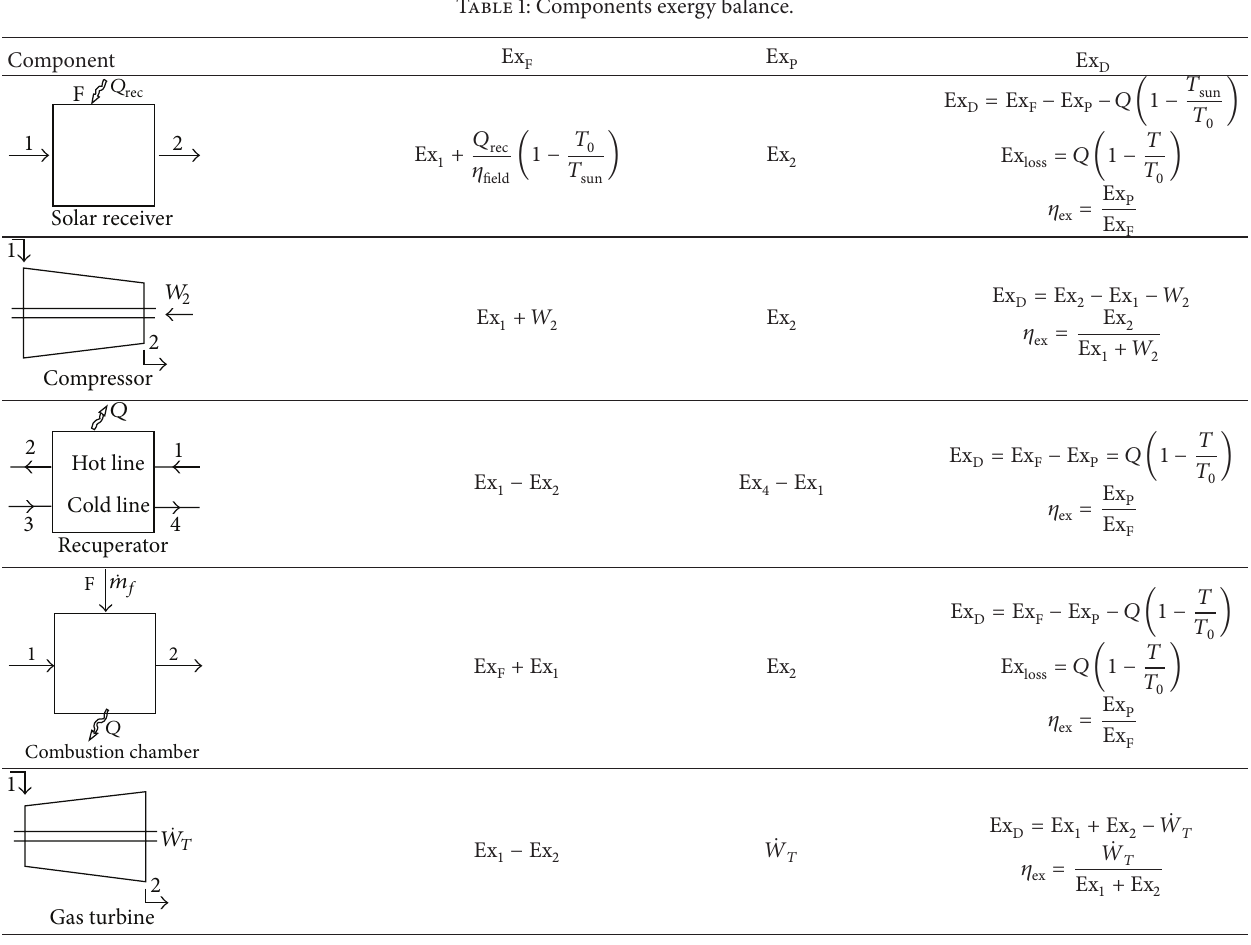
Table 1: Components exergy